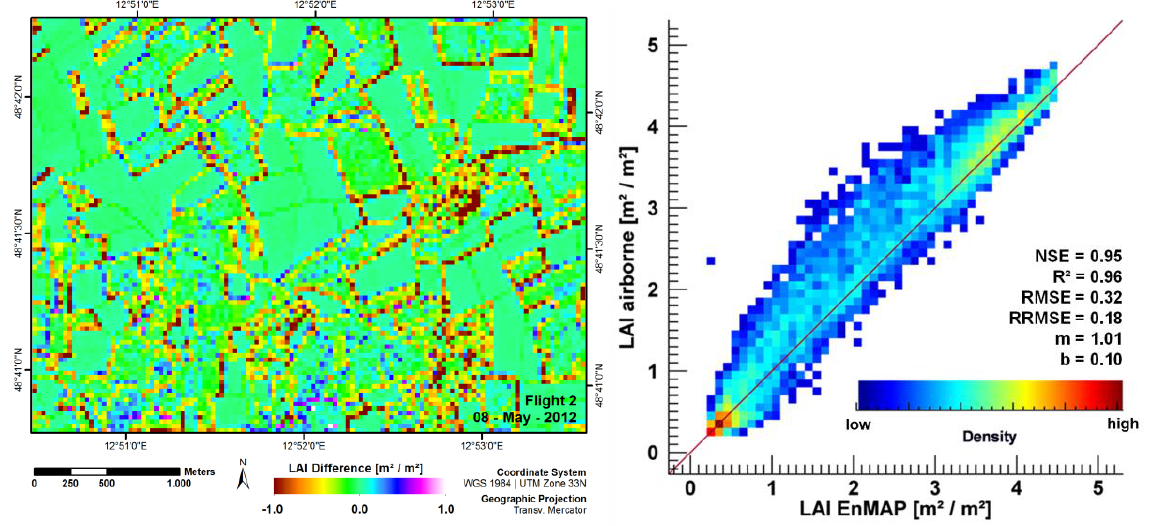
Figure 9. Difference map calculated from the LAI estimations based on simulated EnMAP and upscaled original airborne data ( Left ) and density plot showing a pixel-wise comparison of both spatial data sets ( Right